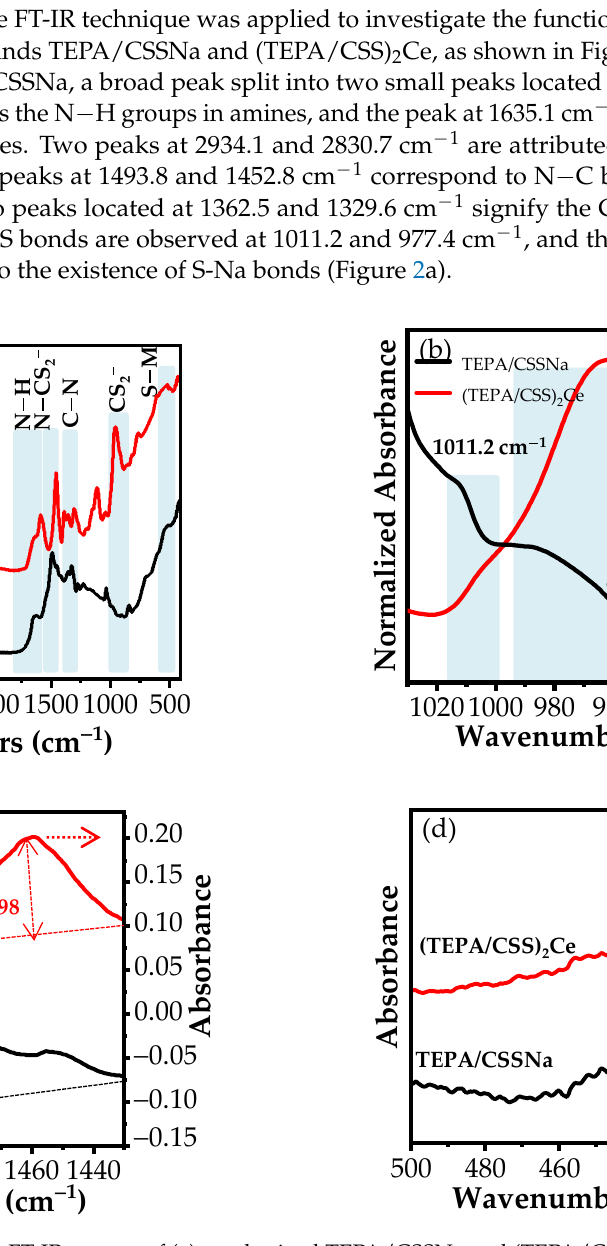
Figure 2. FT-IR spectra of ( a ) synthesized TEPA/CSSNa and (TEPA/CSS) 2 Ce compounds, ( b ) CS 2 − groups, ( c ) N − C in N − CS 2 − groups, and ( d ) S − M bonds (M: metals).